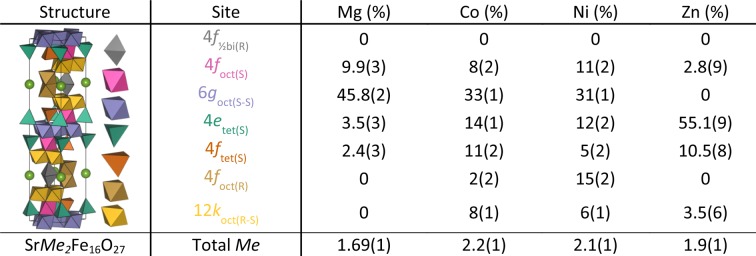
Overview of the occupation of Mes given as a percentage of the full site occupancies and the total amount of Me for one formula unit SrMe
2Fe16O27.